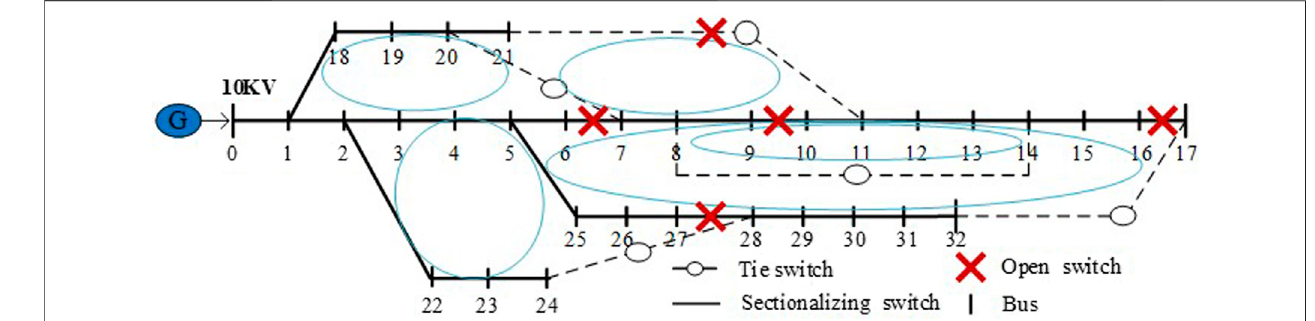
FIGURE 8 | Switching pattern after NR, where the open switches of the minimum power losses in each loop are 7, 34, 10, 17, and 28.